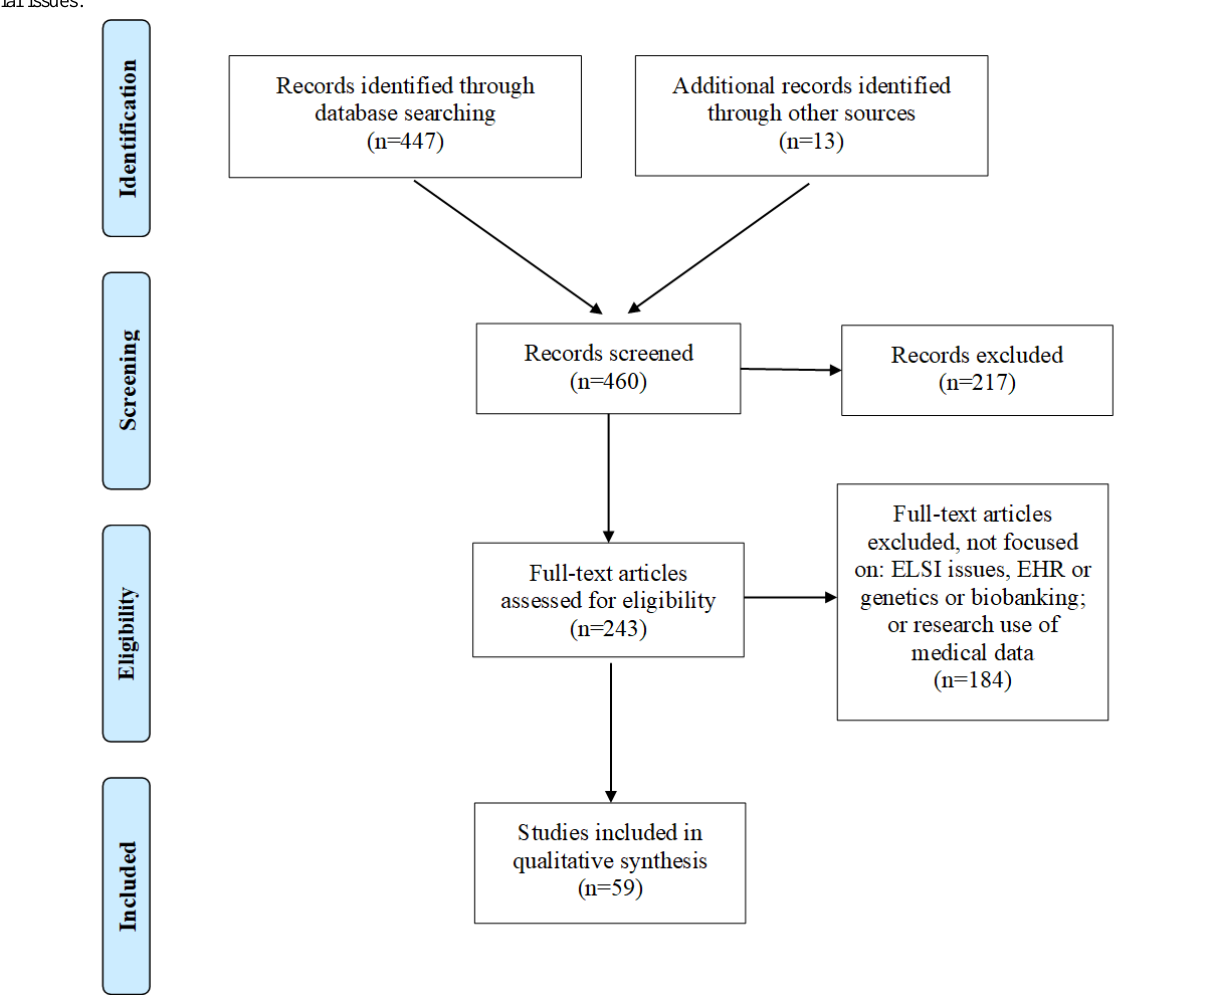
Figure 1. Preferred Reporting Items for Systematic Reviews and Meta-Analyses flowchart. EHR: electronic health record; ELSI: ethical, legal, and social